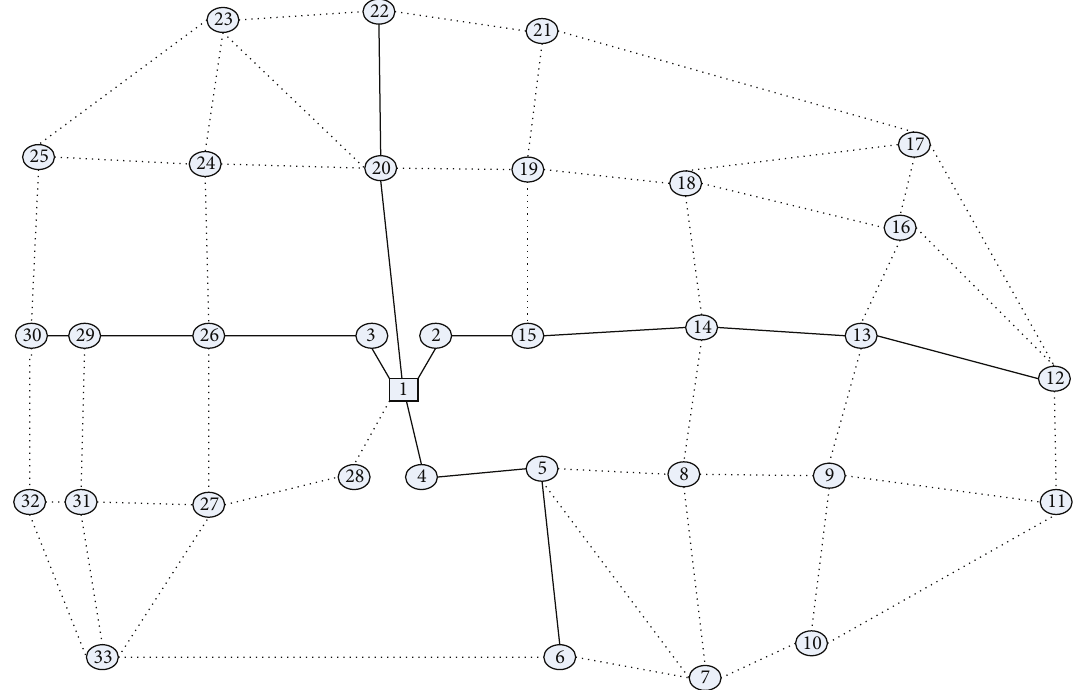
Figure 1: The existing